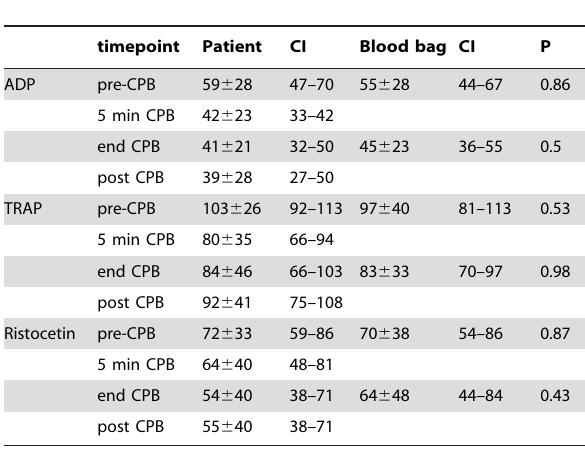
Table 2. Platelet activation in patients on CPB and in ex vivo stored unfractionated heparin-anticoagulated blood.